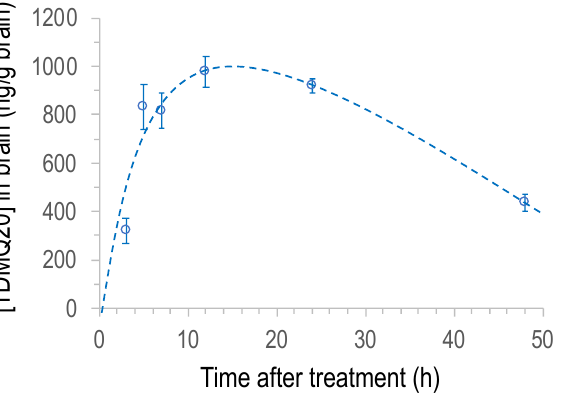
Figure 5. Plot of the concentration of TDMQ20 detected by LC–MS/MS in brain homogenates of male rats as a function of time after oral administration of the drug (25 mg/kg). Each dot is the mean value of 6 animals. Vertical bars stand for SEM values.